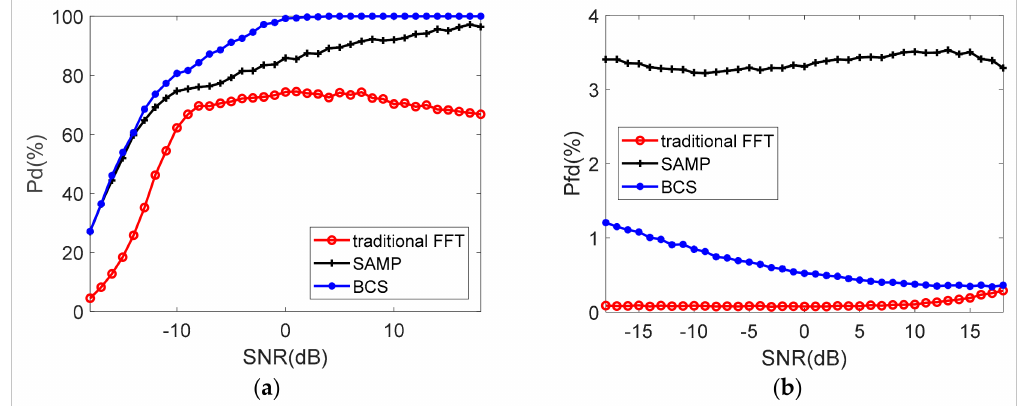
Figure 9. The probability of detection ( a ) and false detection ( b ) (three targets, η =